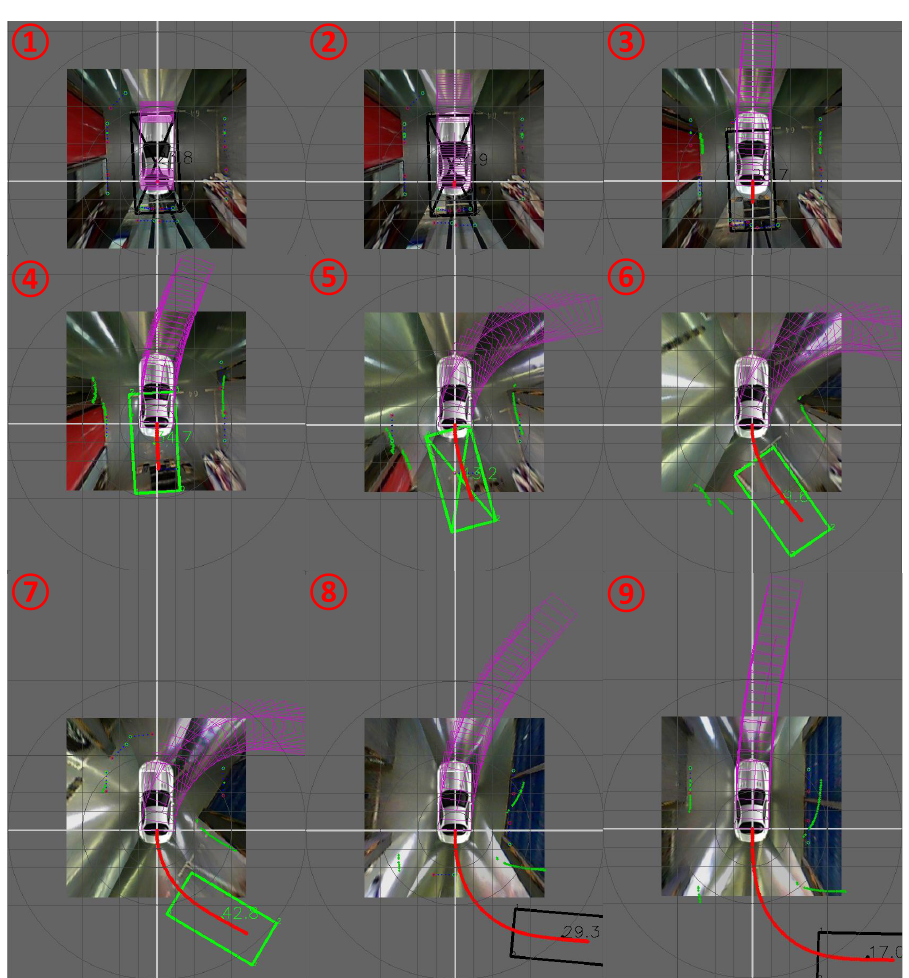
Figure 13. Parking area tracking results. The black rectangles represent vacant. The black rectangles represent unknown parkable status. In the first two frames, the unknown status is because the ego vehicle is inside the parking area and the ultra-sonic sensors could not scan this place. In the last two frames, the unknown status is caused by the distance out of scan range. The cross in a rectangle means a new detecting happened this moment. The number in the middle of a rectangle is the confidence